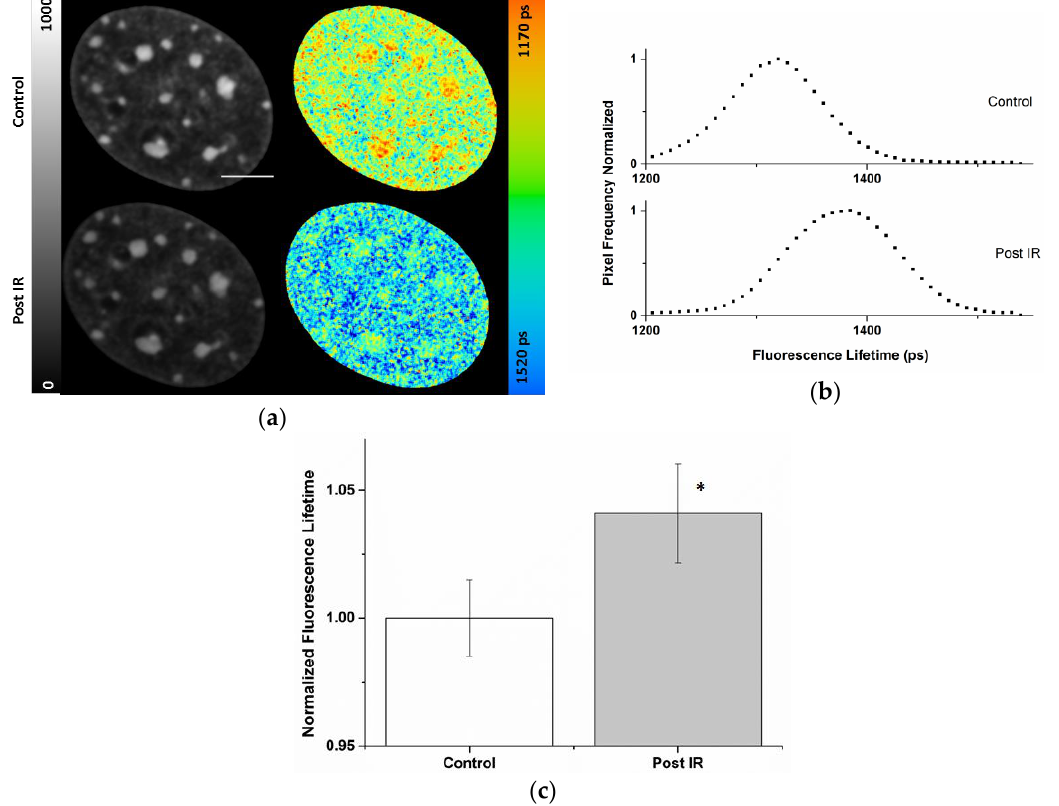
Figure 3. Increased Hoechst 34580 lifetime indicating a global chromatin decompaction after irradiation with X-rays. ( a ) Intensity and lifetime images of the same living NIH/3T3 nucleus before and after 10 Gy X-rays irradiation. Lookup table (LUT) at left side indicates corrected photon counts (0 – 1000). The fluorescence lifetime is decoded on a continuous pseudo-color scale ranging from 1170 to 1520 ps (right). ( b ) Normalized frequencies of lifetime values from the nuclei of ( a ). Quantification of the lifetime indicated a global shift in the lifetime distribution of the Hoechst 34580 after irradiation ( c ). Mean relative increase of fluorescence lifetime of Hoechst 34580 in NIH/3T3 nuclei upon irradiation with 10 Gy X-rays. Asterisk shows (*) p < 0.05 (using Student’s t -test) compared to pre-irradiated nuclei. Scale bar, 5 µm. Error bars indicate mean ± SD; n = 20.